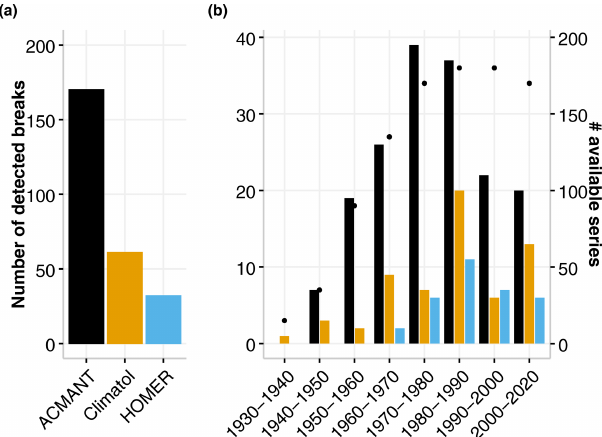
Figure 2. (a) Number of break points identified with ACMANT, Climatol, and HOMER for a total of 184 stations. (b) Number of break points and year of detection retrieved from ACMANT, Clima- tol, and HOMER for a total of 184 stations. The number of available series per decade is indicated with black dots and a corresponding right y axis. All results are for